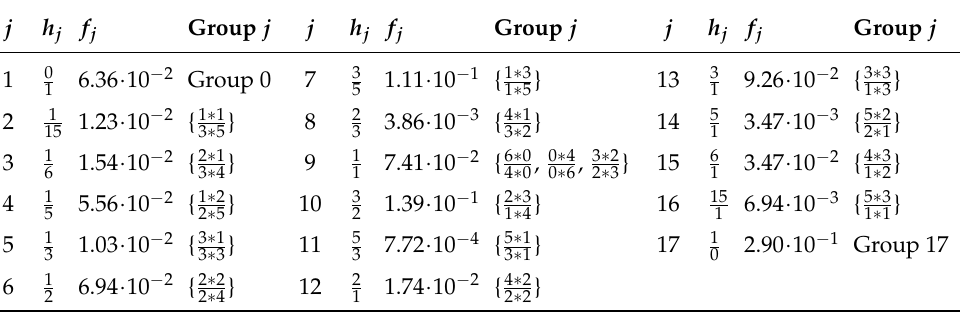
Table A5. Sorted and grouped ORs ( h j ) and their associated probabilities ( f j ) for the data in Table